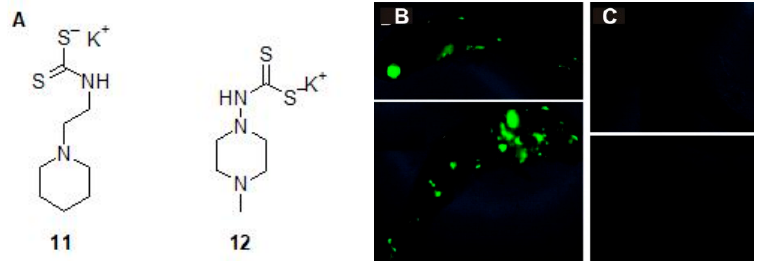
Figure 11. The in vivo inhibition of M. marinum in zebrafish larval model. ( A ) The β -CA inhibitors dithiocarbamate 11 and 12 that were evaluated for toxicity and safety for further use to inhibit growth of M. marinum in zebrafish larvae. ( B ) The zebrafish larvae injected with M. marinum wasabi strain, which expresses a green fluorescent protein. The green fluorescence showing the infection in zebrafish larvae after 6-day post infection not treated with any inhibitor. ( C ) Zebrafish larvae injected with M. marinum and treated with 300 µM concentration of 12 [26].